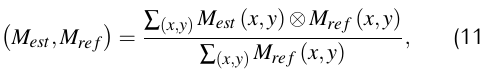
for evaluation is chosen as the segmentation error rate (SER) [18, 19], defined